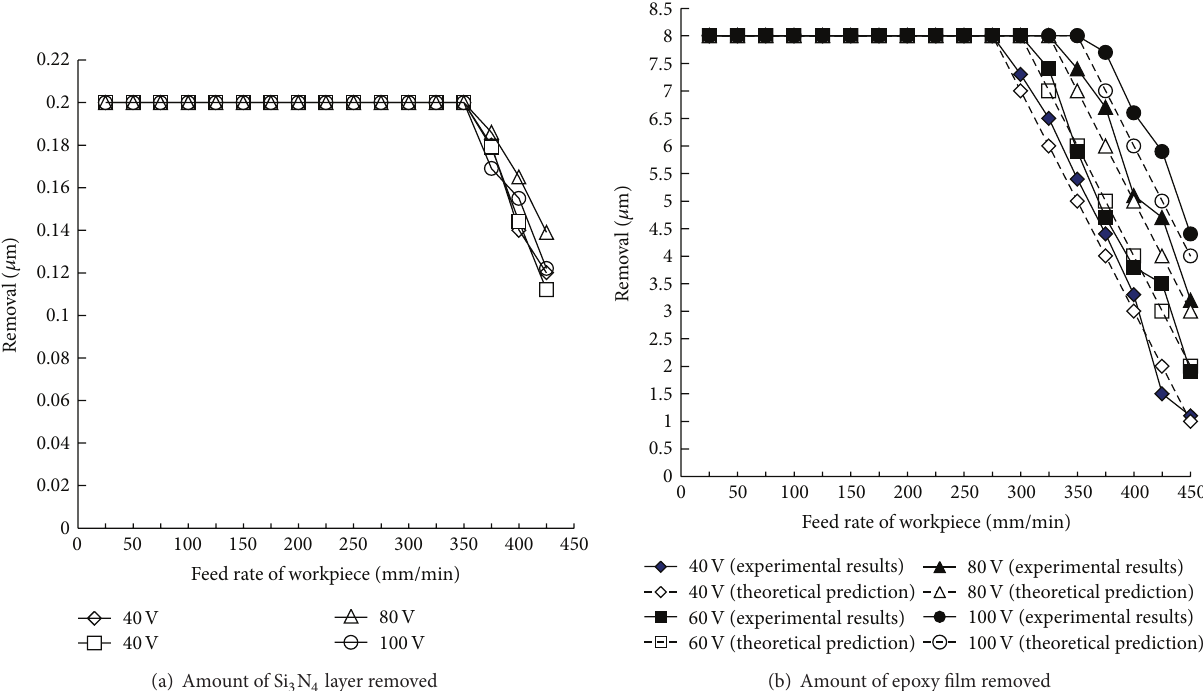
Figure 6: Amount of Si 3 N 4 layer and epoxy film removed at different workpiece feed rates using different currents (phosphoric acid 25% wt, NaNO 3 15% wt, PO4-3-P 5% wt, 60 ∘ C, 40 L/min, continuous DC, 150A, 100kHZ/150W, 4000 Gauss, shift 800 rpm, and tool 900